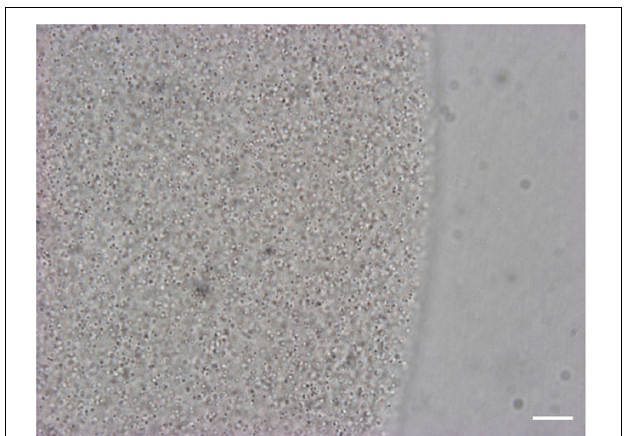
FIGURE 3 | View of the venom of B. pallida in light microscopy. At high magnification, numerous spherical particles of approximately 1 to 2 µ m in diameter are visible in the venom of B. pallida . Scale bar = 50 µ m.